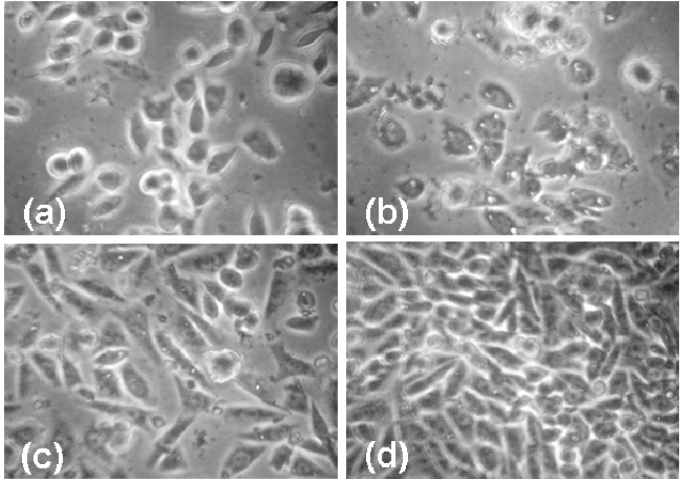
Figure 5. Phase contrast images showing morphology and density effects of dendrimers at 10 mg/mL on CHO cells after 70 hours incubation. (a) 2% Cholesteryl modified dendrimer (C2) (b) 5% Dodecyl modified dendrimer (D1) (c) G Control, no